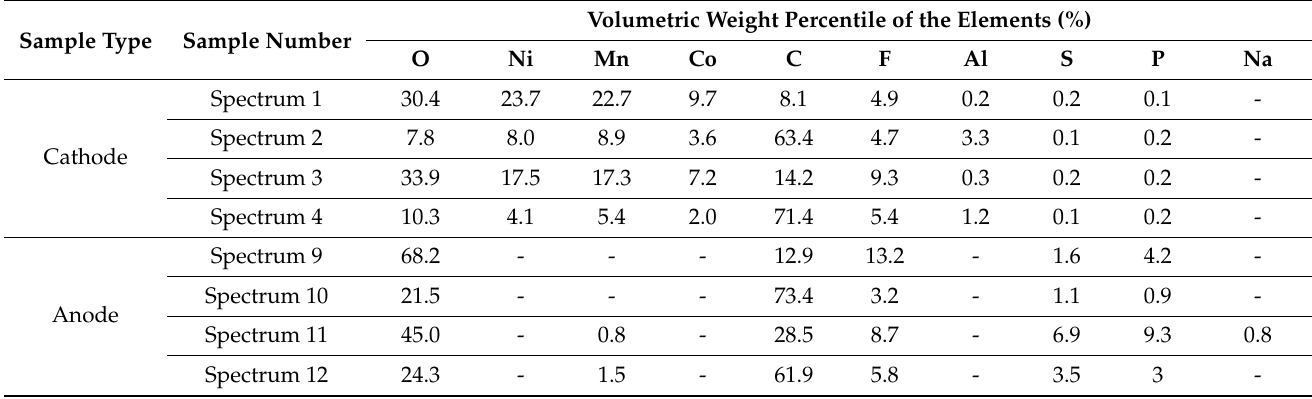
Table A1. Localized volume percentiles of the cathode and anode sample areas from the EDS